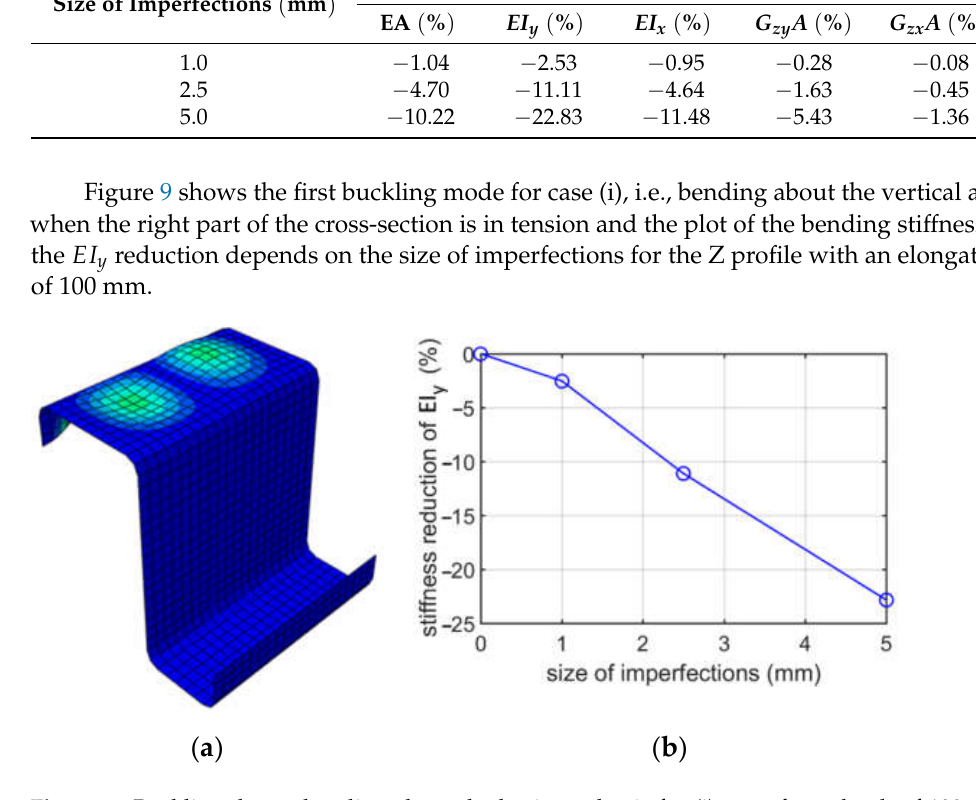
the vertical axis for the case (ii), depending on the value of the imperfection, are presented